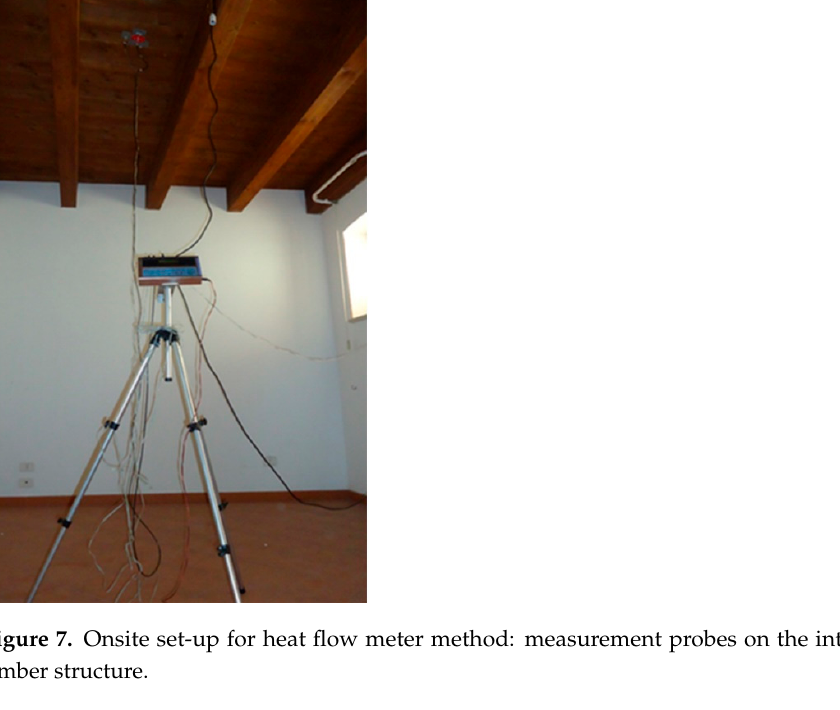
Figure 7. Onsite set-up for heat flow meter method: measurement probes on the intrados of the timber structure.